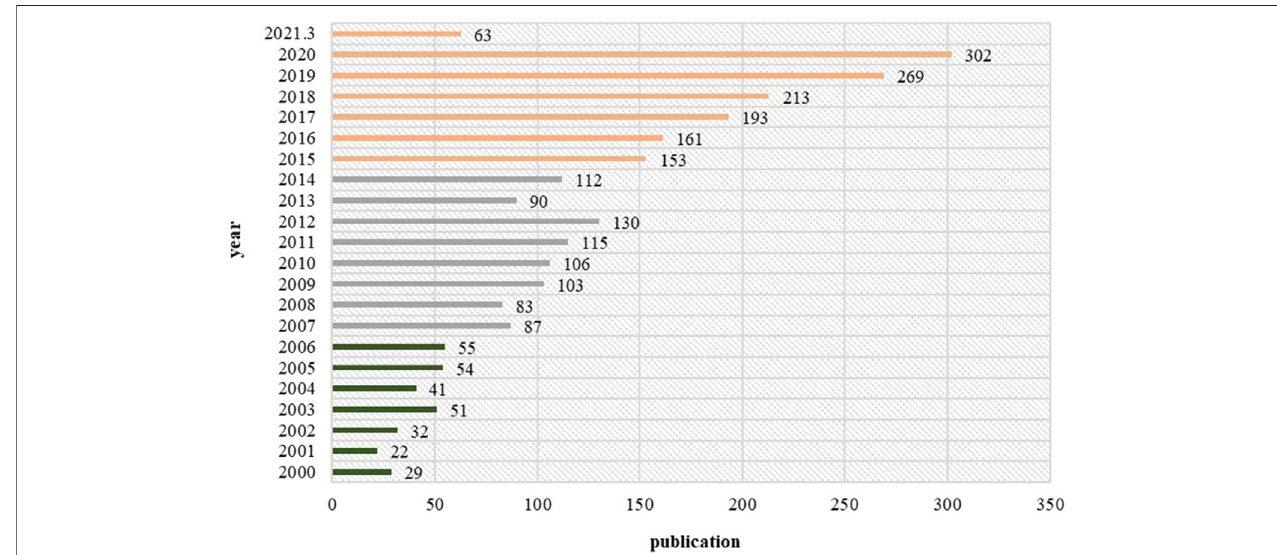
FIGURE 1 | Annual scienti fi c production.